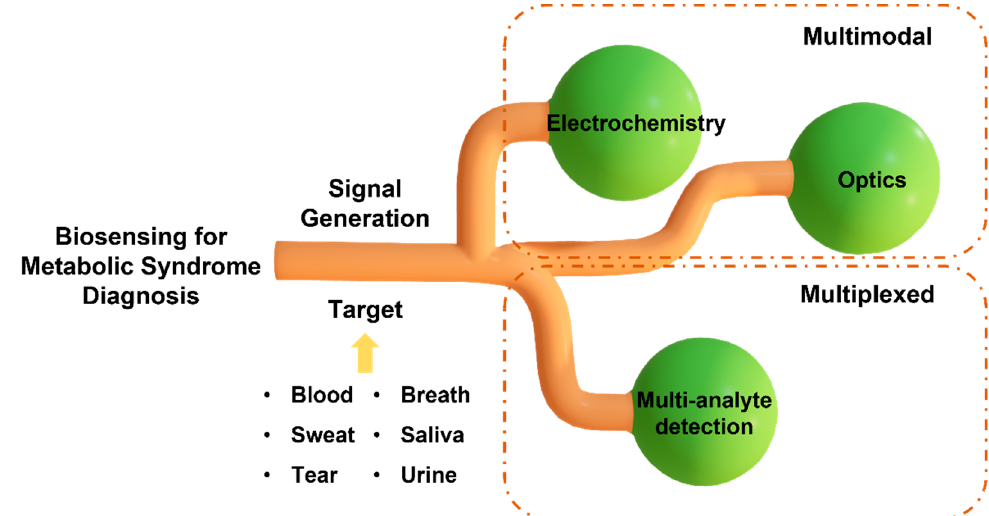
Figure 2. Schematic illustration of multiplexed and multimodal biosensing for diagnosis of metabolic syndrome.